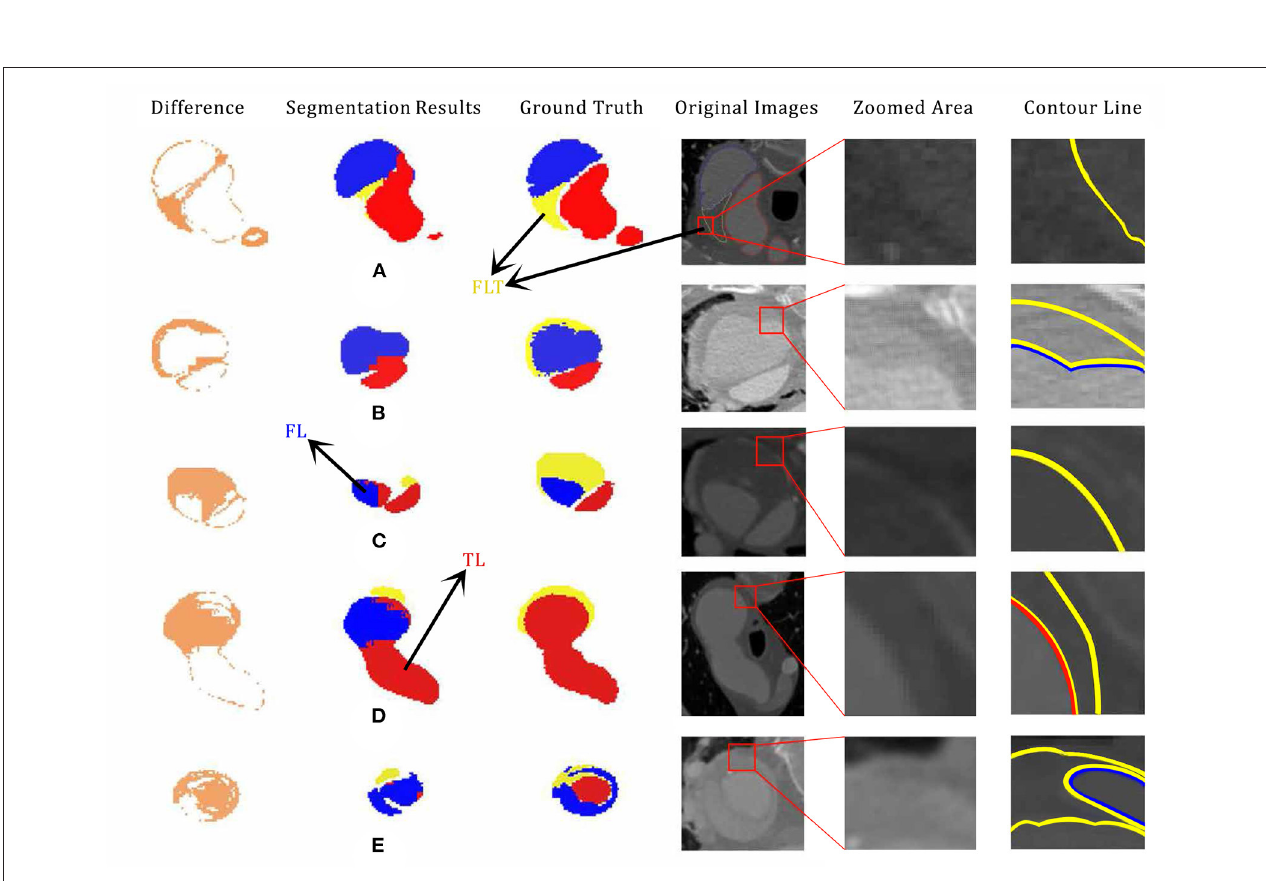
FIGURE 6 | Examples of poor segmentation results (A,B,C,D,E) with their corresponding ground truth, segmentation difference, original CTA image, zoomed, and labeled CTA images. The original pictures and zoomed area of each cases are accompanied. segment failed part showed the impact of the shape and margin of thrombus in segmentation process. Especially, case (D) is the same CT scan picture of Figure 3B with 180 degrees flips vertically. Best viewed in color and position.